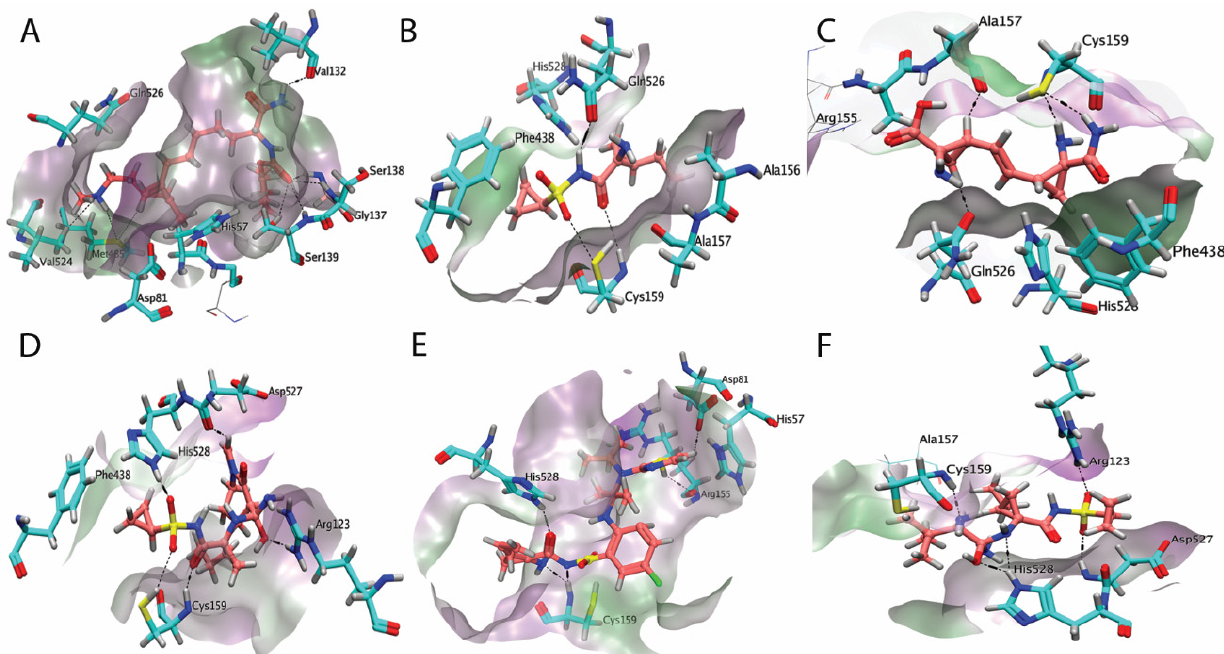
Figure 6. 3D docked conformations of the newly designed inhibitors in the active site of HCV NS3/4A protease. ( A ) The predicted binding mode for the compound 1 . ( B ) The predicted docking pose of compound 4 . ( C ) The predicted binding mode of compound 5 . ( D ) The predicted binding mode of compound 6 . ( E ) The predicted docking mode of compound 7 . ( F ) The predicted docking pose of compound 8 . The ligands are shown in orange color. The purple-colored surface shows a hydrophilic surface area, whereas the greenish-colored surface shows the lipophilic surface area of the active site.